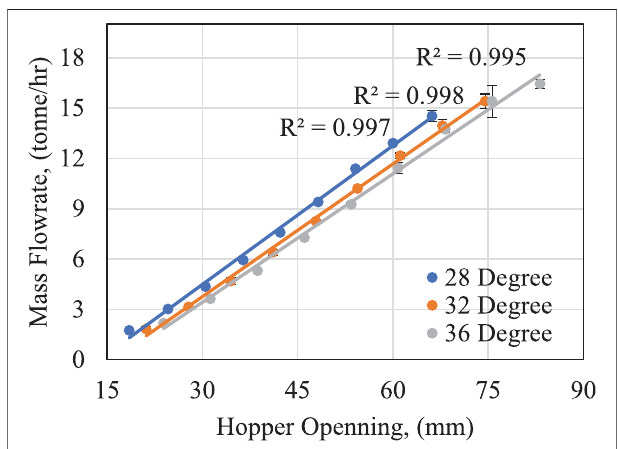
FIGURE 12 | Mass discharge rate data for S7 at variable hopper inclination angles and hopper openings. The error bars represent standard deviation between replicate measurements, but most are within symbol markers.